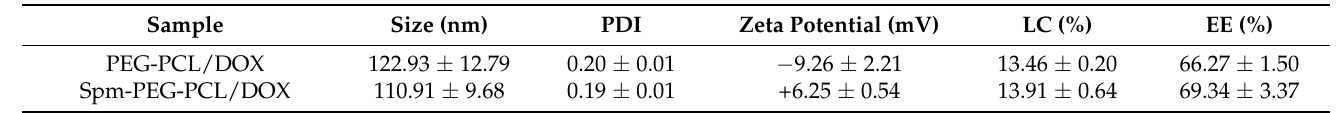
Table 1. Characterization of PEG-PCL/DOX and Spm-PEG-PCL/DOX micelles (mean ± standard deviation, n =